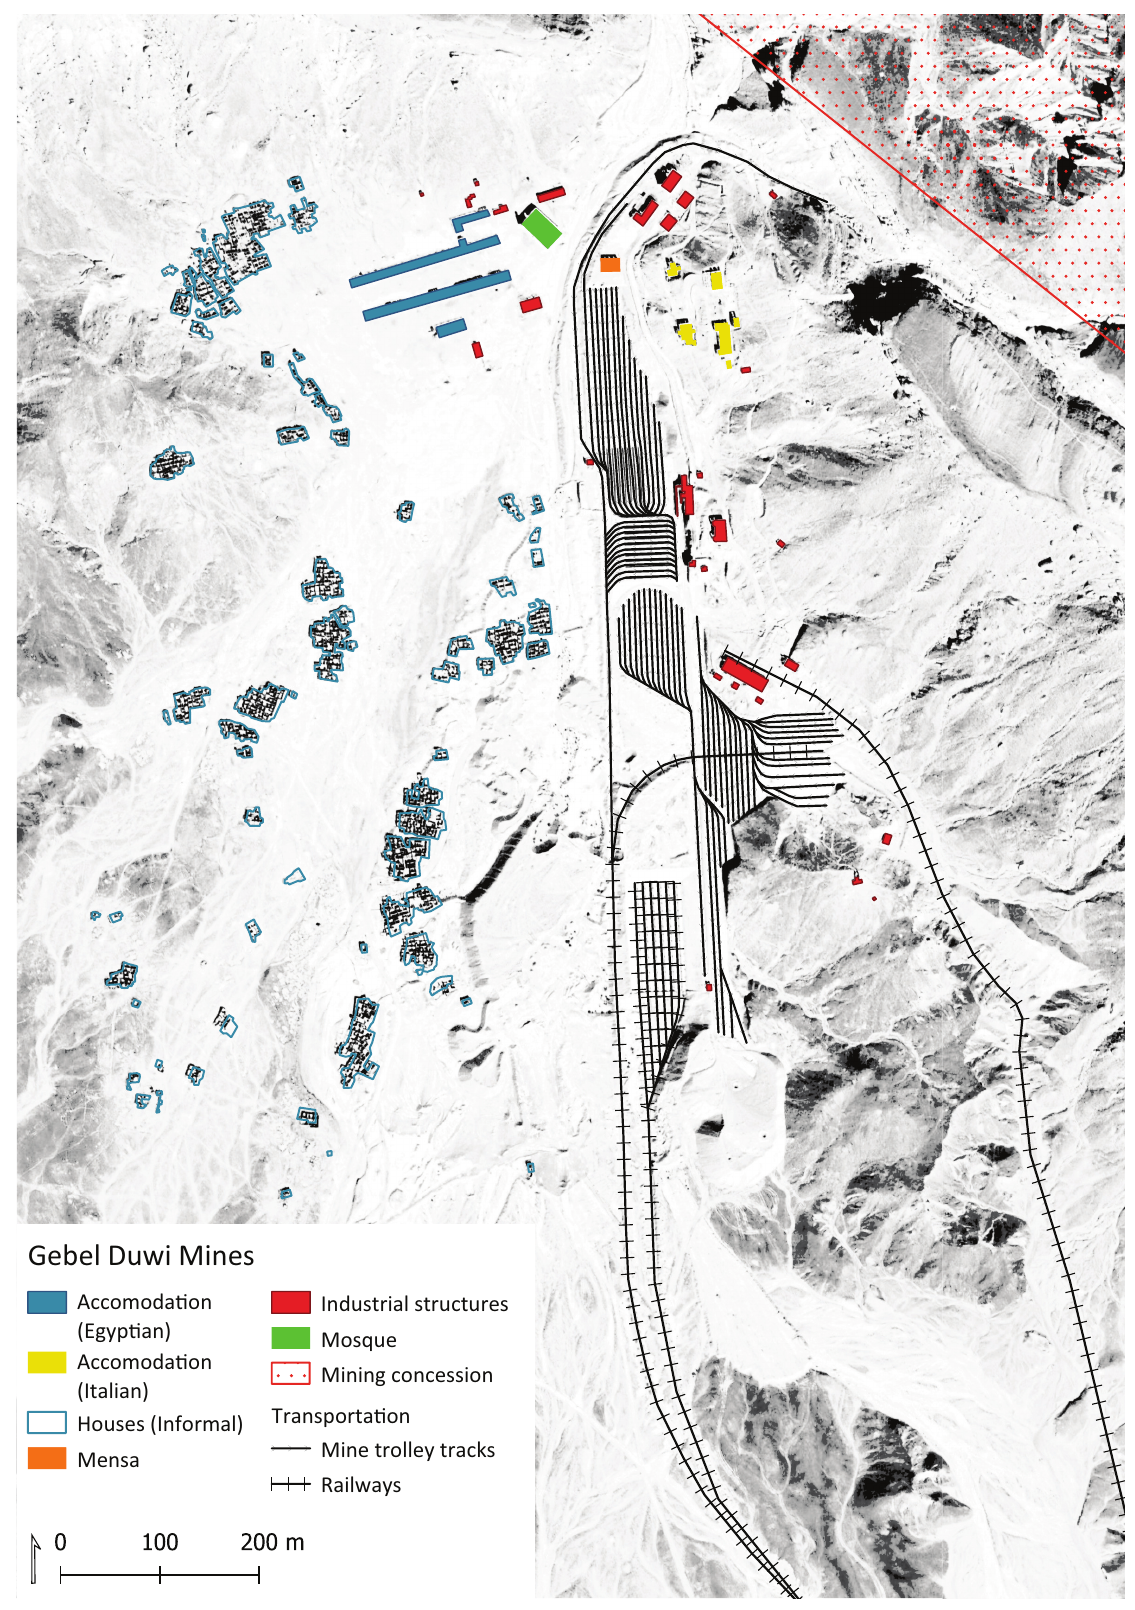
Figure 2. Map of the desert industrial plant in Gebel Duwi. Source: Created by the authors with base map of Google Hybrid,